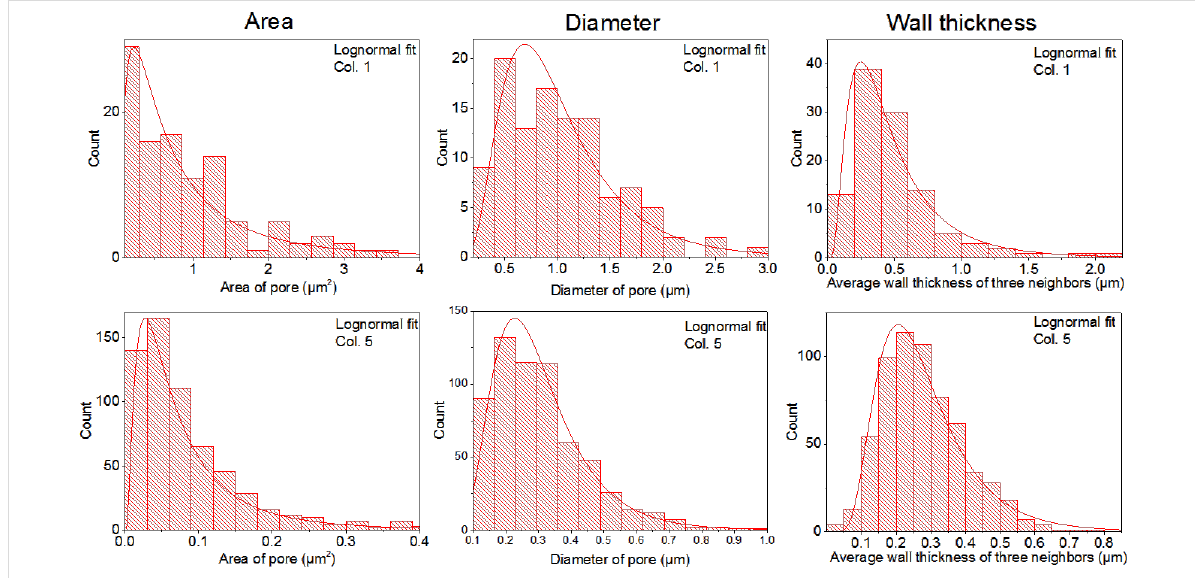
Figure 3: Pore distribution for the indentation columns 1 (top) and 5 (bottom). All presented data fit to a log-normal distribution and satisfy a Kolmogorov–Smirnov test for the goodness of the fits with 5% level. Column one corresponds to the biggest pores within the investigated area, the column five to the smallest